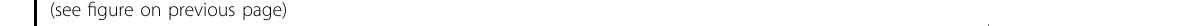
Fig. 3 Single-cell RNA sequencing analysis on CiNs in the striatum. a Representative images of neuron-like EGFP + cells in brain slices collected by patch pipette. Scale bar, 10 μ m. b EGFP expression was con fi rmed in the 51 cells analyzed. c t-SNE analysis of highly variable genes that were detected in 51 EGFP + cells. d Heatmap representation of 1256 differentially expressed genes cross the three clusters. e Enriched GO terms of 1256 differentially expressed genes cross the three clusters. f Gene expression pro fi les of the EGFP + cells using the neuron score analysis. g Expression patterns of striatal neuronal subtype genes in the three clusters. h A heatmap showing expression levels of genes involved in mature neuronal functions in the three clusters. i A heatmap showing expression levels of GABAergic neuronal genes in the three